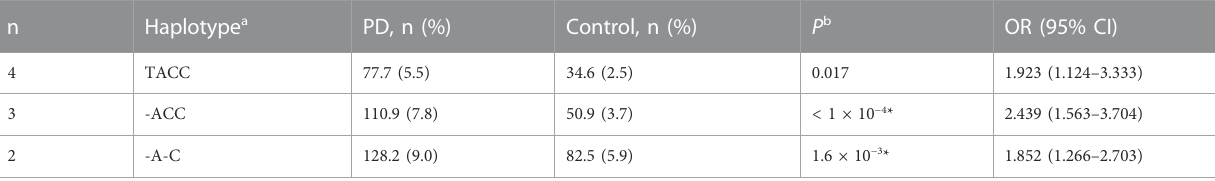
TABLE 4 The highest-risk haplotype analysis of DNMT1 in association with